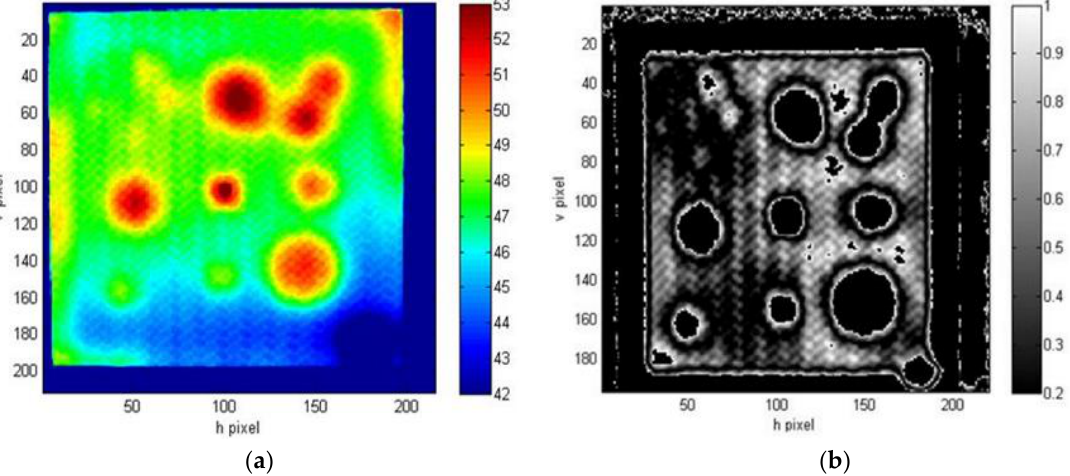
Figure 15. Comparison between raw thermal map ( a ) and contrast image ( b ) of CFRP Plate II on Side A obtained after 5 cooling seconds after heating pulse of 15 s.